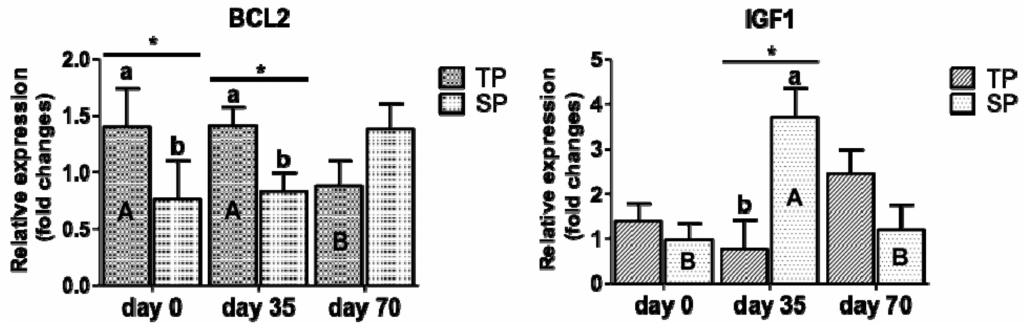
Figure 2. Relative expression of genes associated to cell turnover / lactogenesis in the mammary gland (BCL2 and IGF1) of twin- and single bearing ewes according to time (LSM ± SEM). TP: twin-bearing ewes (n = 6); SP: single-bearing ewes (n = 7); BCL2: B-cell CLL / lymphoma 2; IGF1: insulin like growth factor 1; day 0: birth, day 35: day 35 post-partum and day 70: day 70 post-partum; di ff erent small letters (a,b) denote significant di ff erences between groups within each measuring time at p ≤ 0.05 (*); Di ff erent capital letters (A, B) denote significant di ff erences of each group according to time p ≤ 0